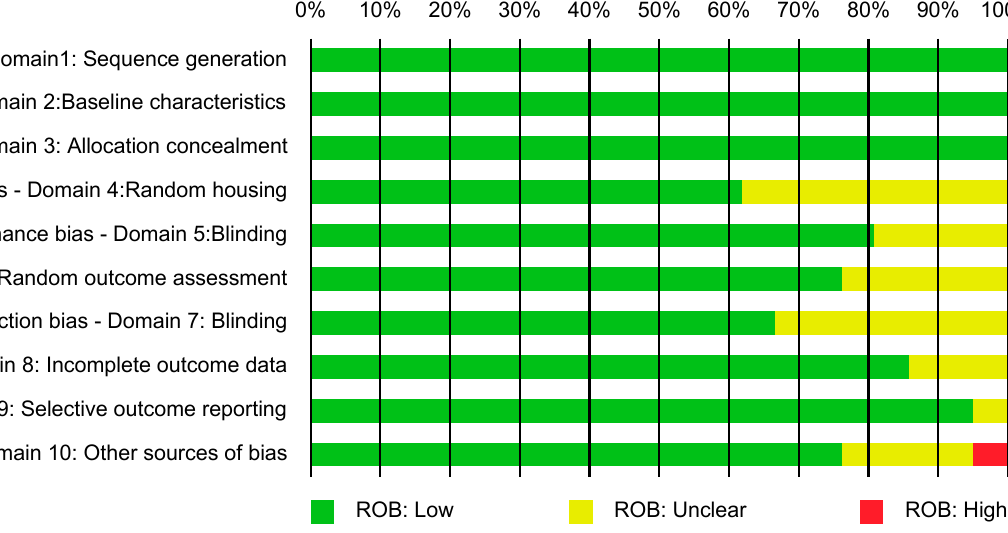
Figure 3. The risk-of-bias assessment graph using the SYRCLE Risk of Bias Tool dedicated for animal studies (ROB, risk of bias).